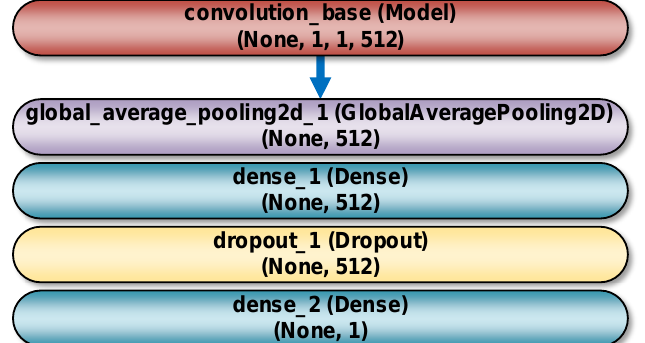
Figure 9. A general scheme for the implementation of a deep network that consists of a convolution base and own classifier. The meaning of the Keras classes is as follows: GlobalAveragePooling2D — a layer responsible for the global average pooling operation for spatial data; Dense — a densely connected layer; Dropout — a layer that limits the excessive adjustment of the model to the training data. The feature map has a shape (samples, height, width, and channels). The first dimension equal to None means any number of samples.